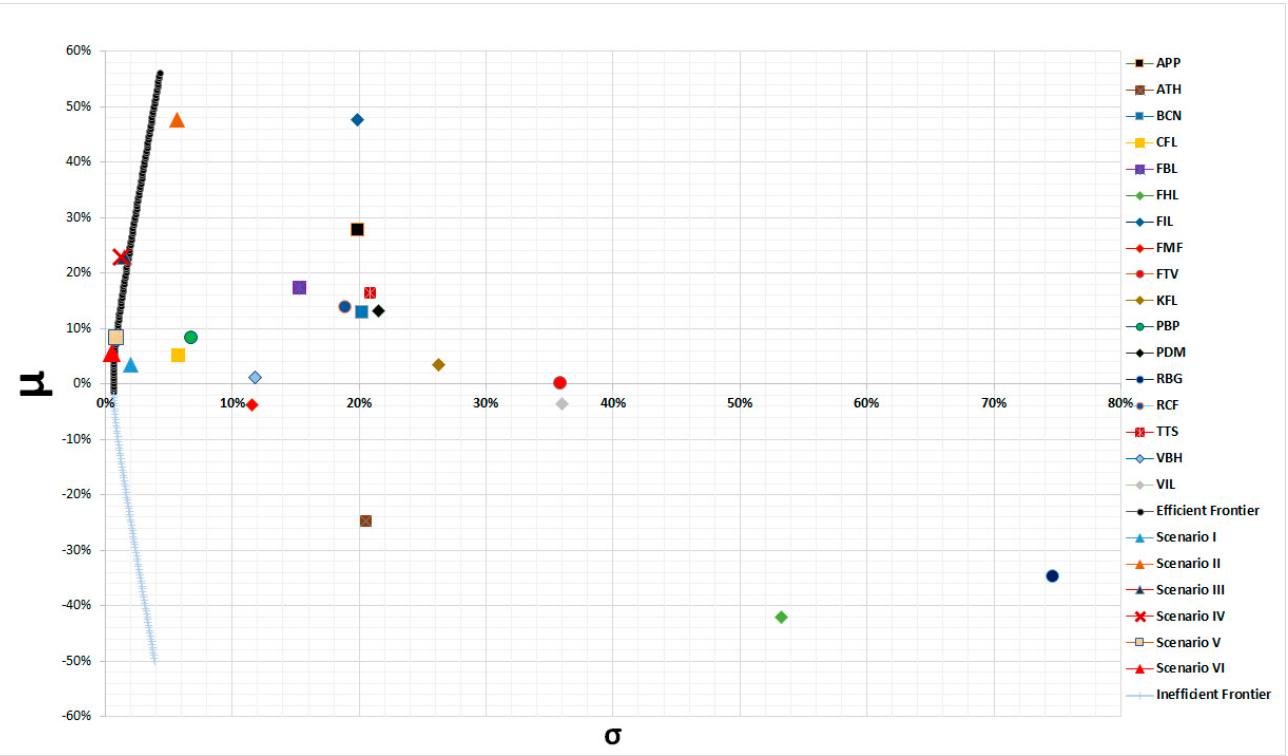
Figure 6. Plot of Stock and Portfolio Risk-Returns and Efficient Frontier Based on Mean–Variance Analysis. Source: Authors’ calculations, based on the monthly returns data from SEP-2019 to FEB-2022.